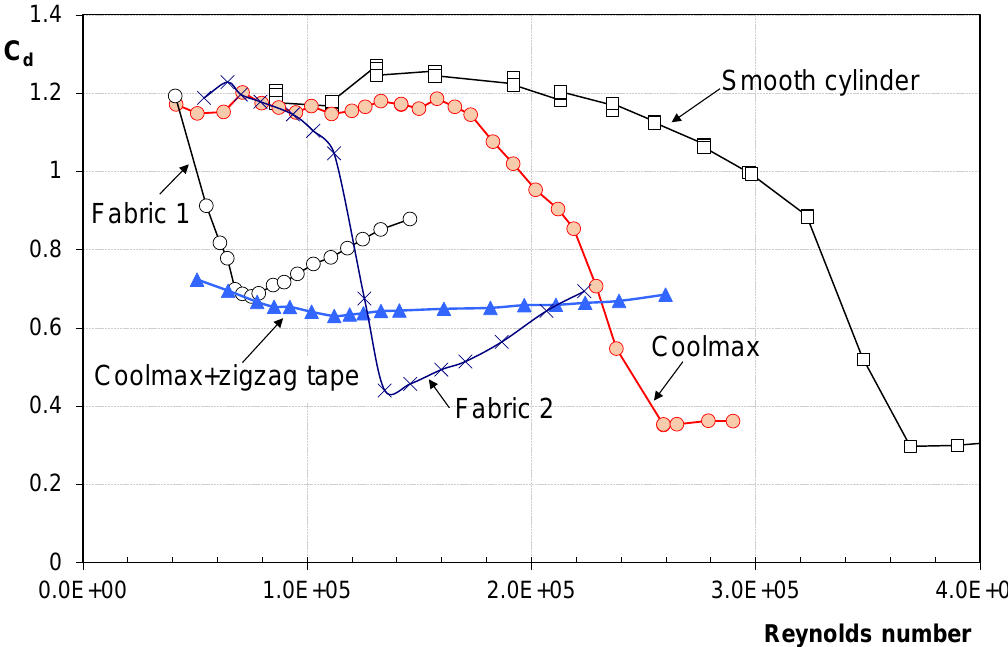
Figure 13. The impact of zigzag tape and rough fabrics on the drag coefficient of a circular cylinder. Nagano foam zigzag tape t = 1.2 mm, at an azimuth of 45 degrees. Cylinder span, 90 cm. Table 6. The effect of altitude on the lower-leg average Reynolds number, men’s 5000 m. Location Alt.